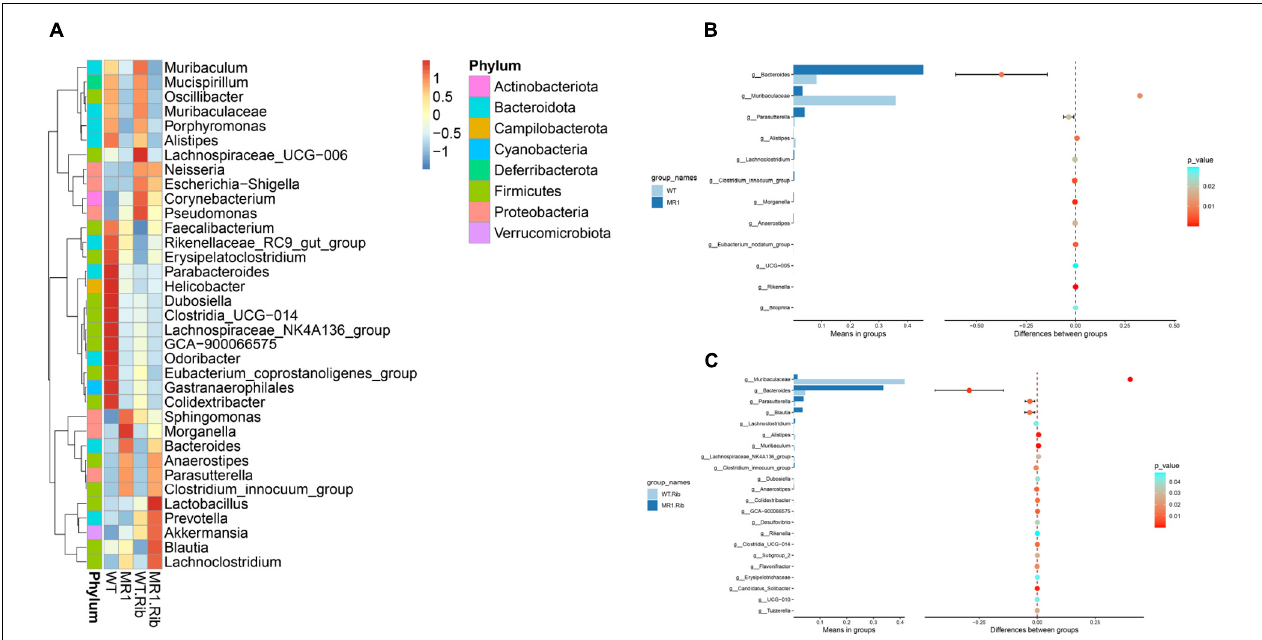
FIGURE 4 | Examination of the differences in the gut microbiota between groups at the genus level. (A) Heatmap depicting the normalized abundance of each bacterial genus in individuals. (B) T -test of the species differences between the WT and MR1 − / − groups at the genus level. (C) T -test of the species differences between the riboflavin-pretreated WT and MR1 − / − groups at the genus